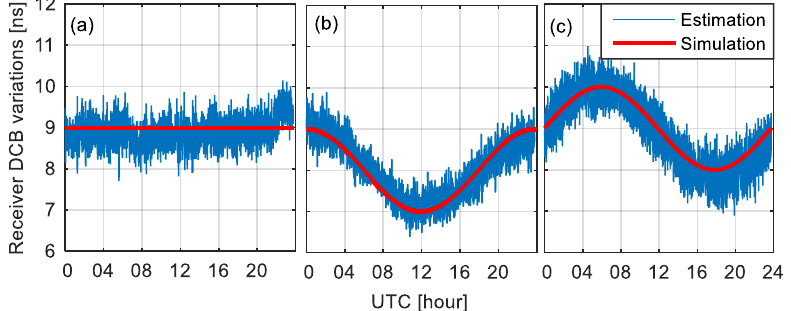
Figure 1. Simulated values (red line) versus estimates (blue line) of receiver DCB variations at site ALG3 on DOY 07, 2017: ( a ) DCB ( i ) = 0, ( b ) DCB ( i ) = C os (cid:16) (cid:17) 2 π · i ( c ) DCB ( i ) = 2 · sin for epochs i = 1,2 . . . n , where n = 2880 and the interval is 30 s. n In Figure 2, the BR-DCBs are plotted for three baselines, namely, DLFT-DLF4, DLFT- DLF5 and DLF4-DLF5, on day 172 in 2010. The red lines depict the BR-DCB estimates